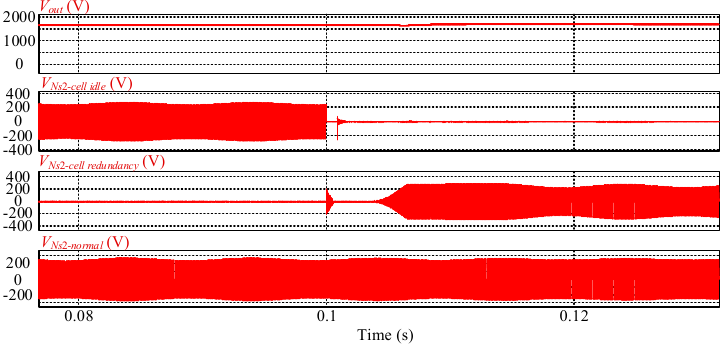
Figure 17. Fault tolerance operation with redundancy.